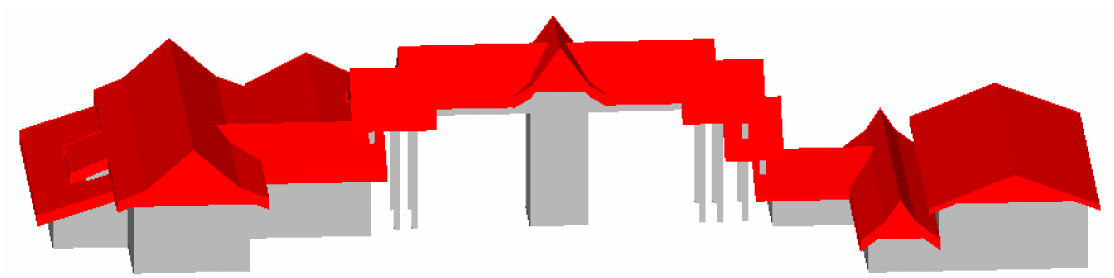
Figure 10. Resulting 3D model of building in CityGML format.